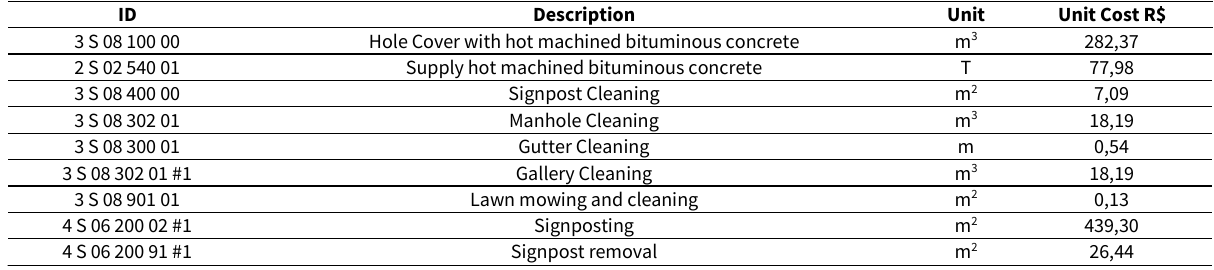
Table 1. DER/DF Pricing Table Services - May 2018